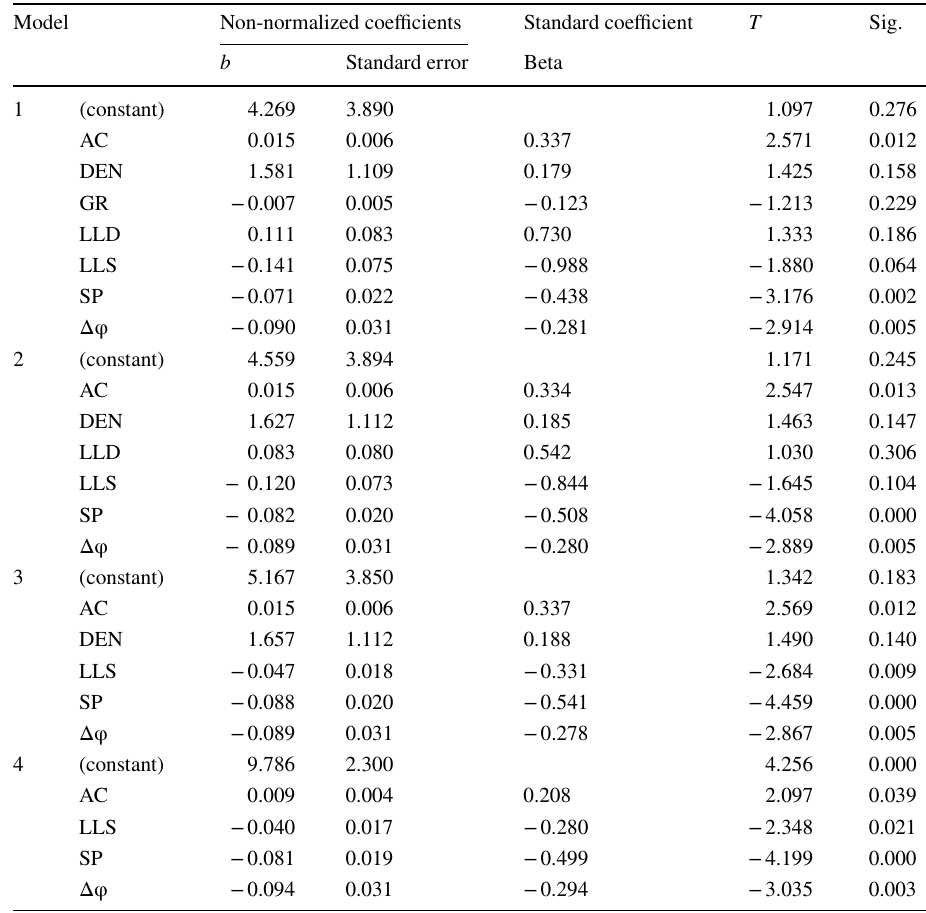
Table 5 The statistics result of backward